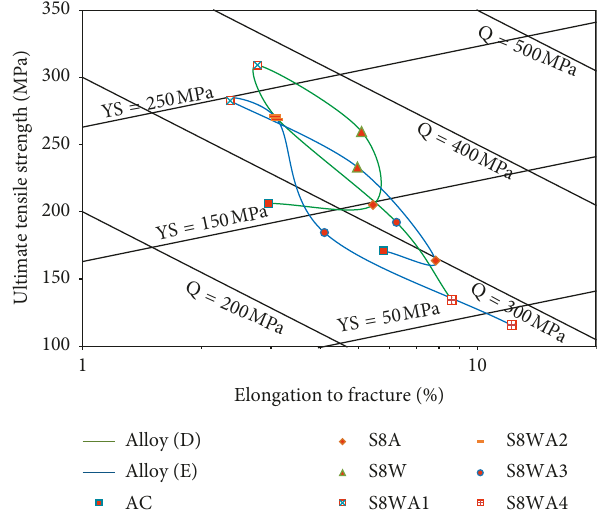
Figure 13: Quality chart showing relationship between UTS and % El for the D and E alloys in the as-cast and six heat treatment conditions with SHT for 8